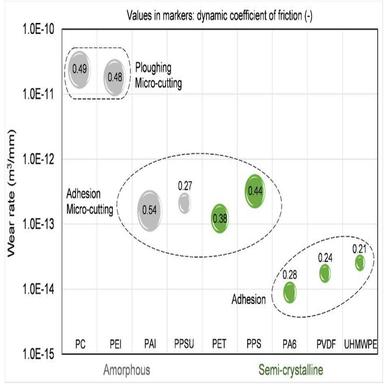
Wear rate and dynamic friction coefficient of thermoplastics.